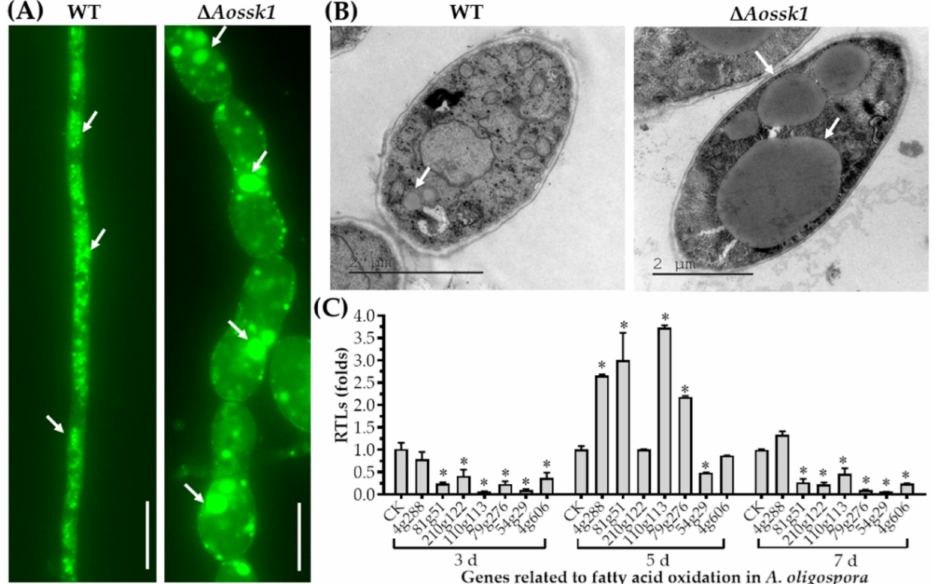
Figure 2. Comparison of lipid droplets (LDs) and transcription of genes related to fatty acid oxidation between ∆ Aossk1 mutant and WT strain. ( A ) Comparison of LDs in the hyphal cells of the WT and ∆ Aossk1 mutant strains. LDs were stained with 10 µ g/mL BODIPY dye. Arrows: LDs. Bar = 10 µ m. ( B ) Observation of LDs using transmission electron microscopy. Arrows: LDs. ( C ) Comparison of relative transcript levels (RTLs) of genes related to fatty acid oxidation between ∆ Aossk1 mutant and WT strain on the 3rd, 5th, and 7th days. CK (which has an RTL of 1) was used as a standard for the statistical analysis of the RTLs. An asterisk indicates a significant difference between ∆ Aossk1 mutant and WT strain (Tukey’s HSD, p < 0.05).